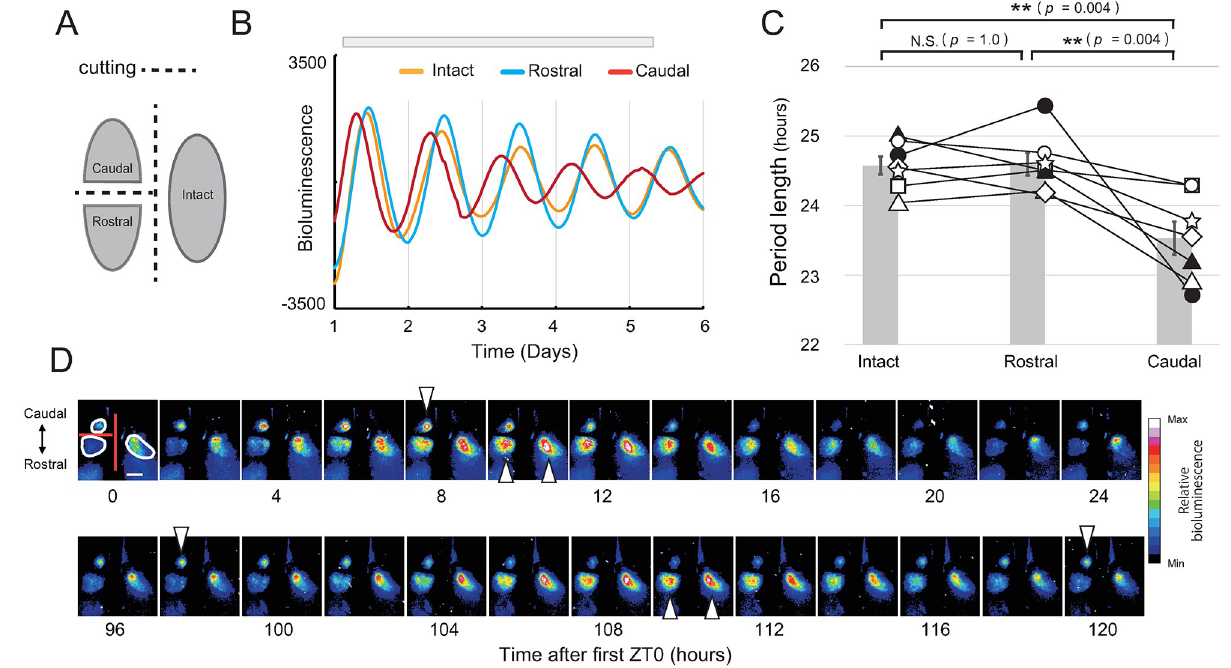
Fig 4. Effect of rostro-caudal separation on Per2 ::dLuc bioluminescence rhythm. (A) Schematic diagram of the dissected SCN. ROIs were set by outlines of Caudal, Rostral and Intact, and the circadian period of the bioluminescence from each ROI was measured. (B) One representative Per2 ::dLuc bioluminescence rhythm from three ROIs of a single slice. Gray bar indicates the period for curve fitting. (C) Circadian period of each ROI (n = 7). The period lengths were 23.5 ± 0.2, 24.6 ± 0.2, 24.6 ± 0.1, (Mean ± SE) in Caudal, Rostral and Intact, respectively. Repeated measures one-way ANOVA with post-hoc Bonferroni test: �� p < 0.01, N.S. = not significant. (D) Representative bioluminescence images of the SCN dissected by scalpel. White lines represent the outlines of Caudal, Rostral and Intact. White arrowheads indicate the peak phases of each fragment. Scale bar: 500 μ m.